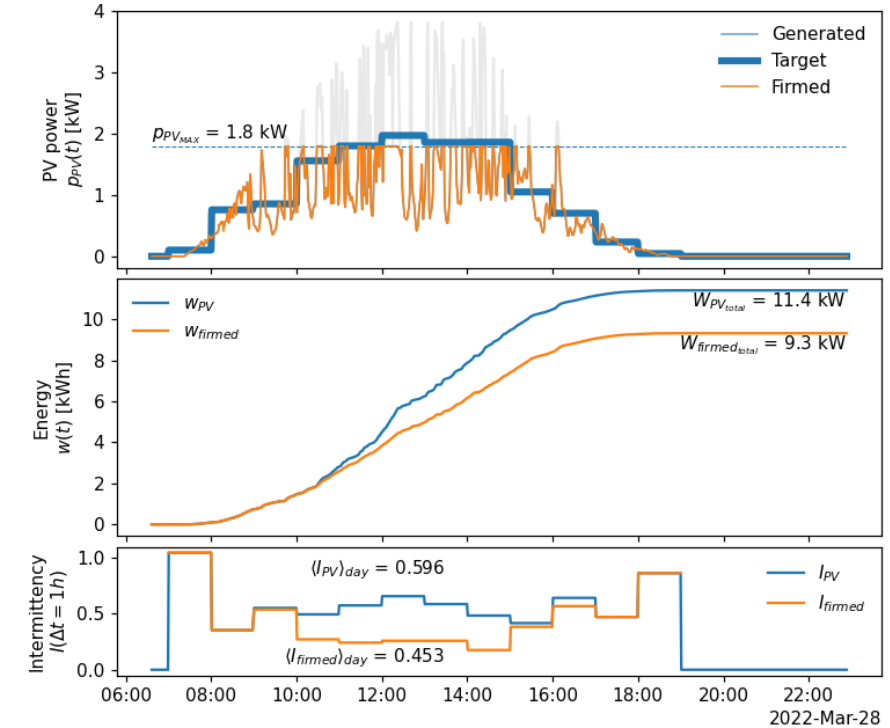
Figure 29. Reducing intermittency without storage by limiting